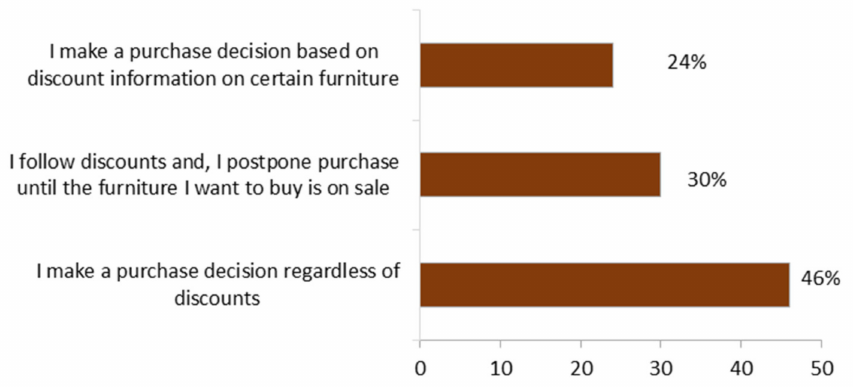
Figure 5. Consumer decisions about furniture based on discount information ( N =